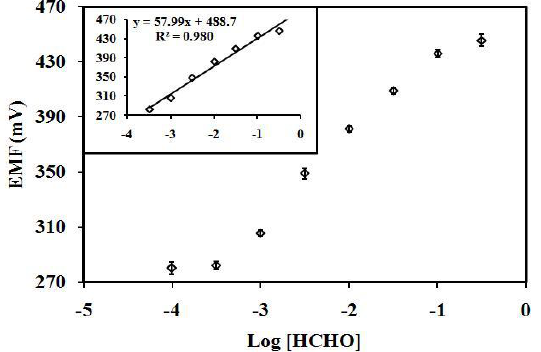
Figure 5. The response of a AOX-poly(nBA-NAS) microspheres based biosensor to formaldehyde in 10 mM Tris-HCl buffer, pH 6.5.